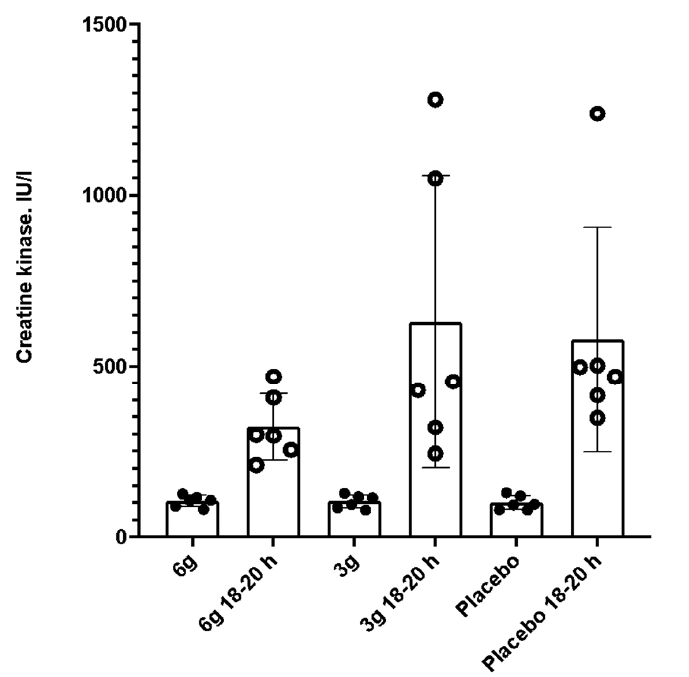
Figure 3. Creatine-kinase changes before and after the field-based soccer-specific